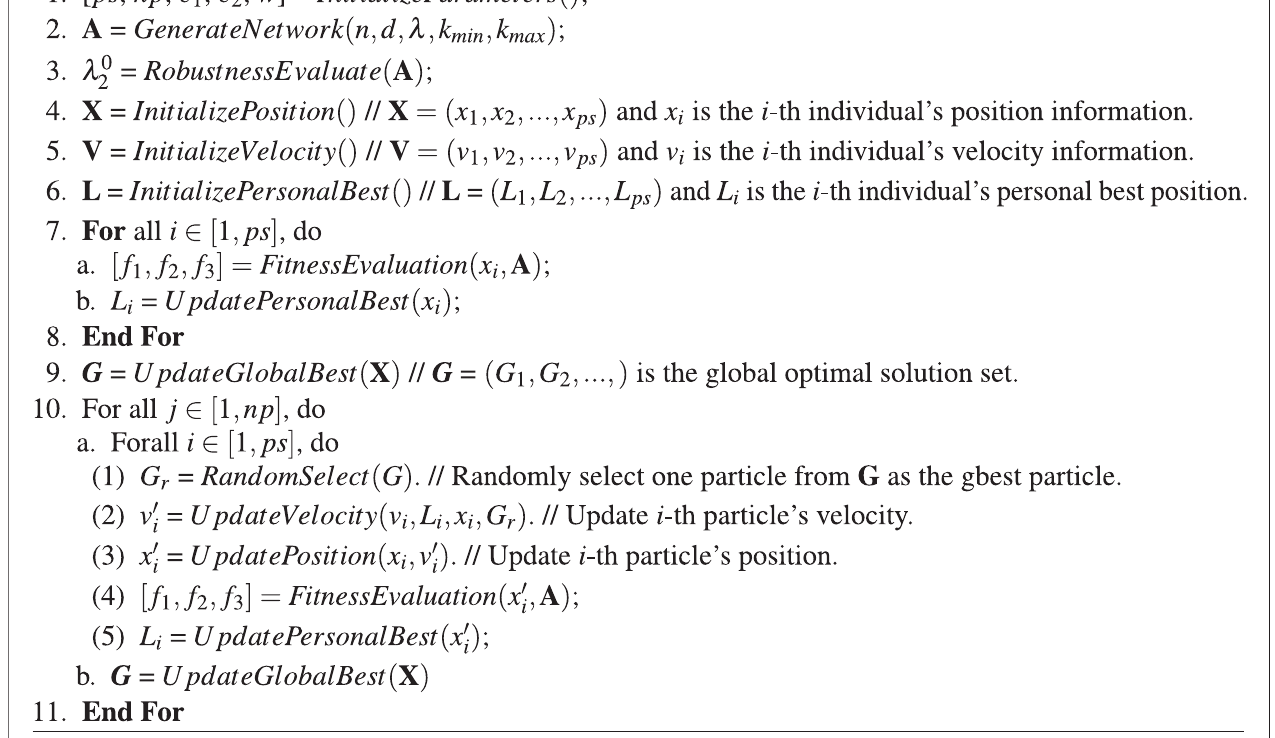
Algorithm 1 evaluates a particle based on the proposed multiobjective